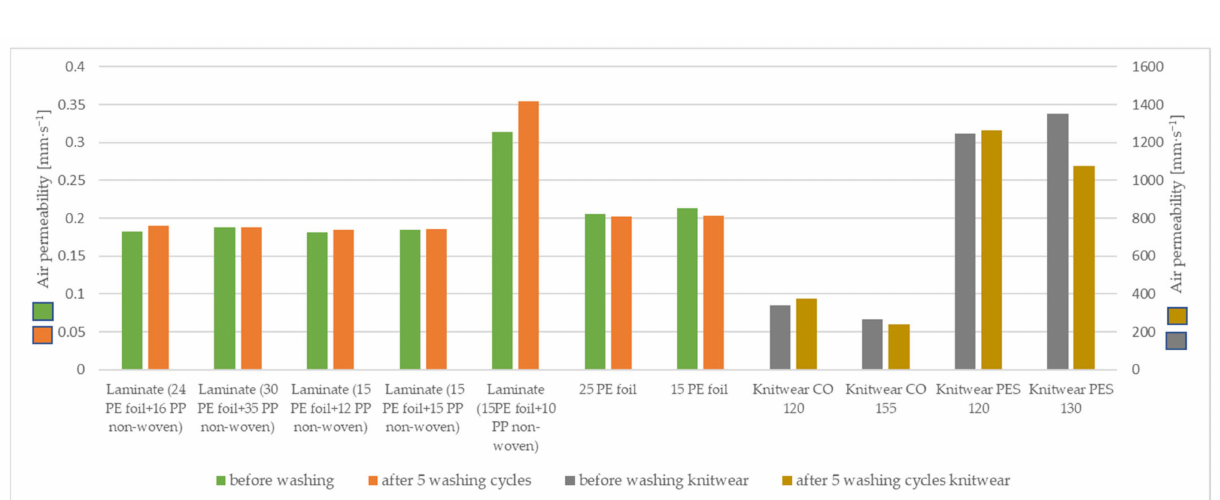
Figure 12. Air permeability of tested materials: before and after 5 washing